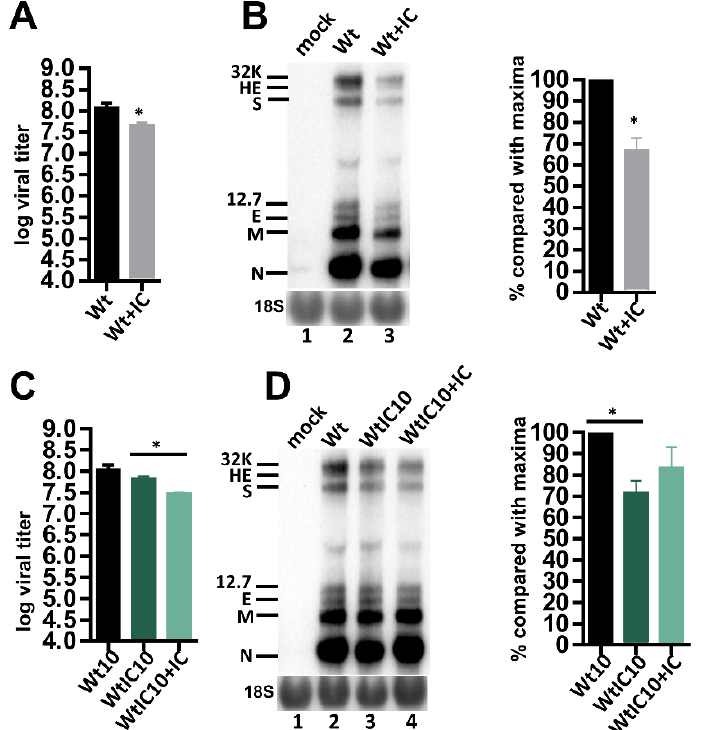
Figure 5. E ff ects of poly IC-induced innate immunity on the virus fitness in HRT-18 cells. ( A ) The viral titer of Wt and Wt + IC at VP0 as determined by the plaque assay. Wt indicates the virus collected from wt BCoV-infected HRT-18 cells in the absence of poly IC at VP0. Wt + IC indicates the virus collected from wt BCoV-infected HRT-18 cells in the presence of poly IC at VP0. ( B ) Left panel: determination of BCoV RNA synthesis from HRT-18 cells infected with wt BCoV in the absence (Wt) or presence (Wt + IC) of poly IC at VP0 by Northern blotting. Right panel: relative amounts of BCoV RNA between Wt and Wt + IC based on the results shown in the left panel. ( C ) Comparison of the viral titer between viruses collected from Wt10- and WtIC10-infected HRT-18 cells in the absence of poly IC, and between viruses collected from WtIC10-infected HRT-18 cells in the absence of poly IC (i.e., WtIC10) and from WtIC10-infected HRT-18 cells in the presence of poly IC (i.e., WtIC10 + IC), as determined by the plaque assay. Wt10 is the virus collected from wt BCoV-infected HRT-18 cells at VP10 in the absence of poly IC. WtIC10 is the virus collected from wt BCoV-infected HRT-18 cells at VP10 in the presence of poly IC. ( D ) Left panel: determination of BCoV RNA synthesis from Wt10- and WtIC10-infected HRT-18 cells in the absence of poly IC (lanes 2 and 3, respectively) and from WtIC10-infected HRT-18 cells in the presence of poly IC (WtIC10 + IC, lane 4) by Northern blotting. Right panel: relative amounts of BCoV RNA based on the results shown in the left panel. 32K: 32 kDa protein, HE: hemagglutinin / esterase, S: spike protein, 12.7: 12.7 kDa protein, E: envelope protein, M: membrane protein, N: nucleocapsid protein, 18S: 18S rRNA. The values in ( A – D ) represent the mean ± standard deviation (SD) of three individual experiments. The statistical significance was evaluated using a paired t -test: * p < 0.05. 3.6. The WtIC10 Selected by Poly IC-Induced Innate Immunity Adapts to ML Cells with Better E ffi ciency than Wt BCoV